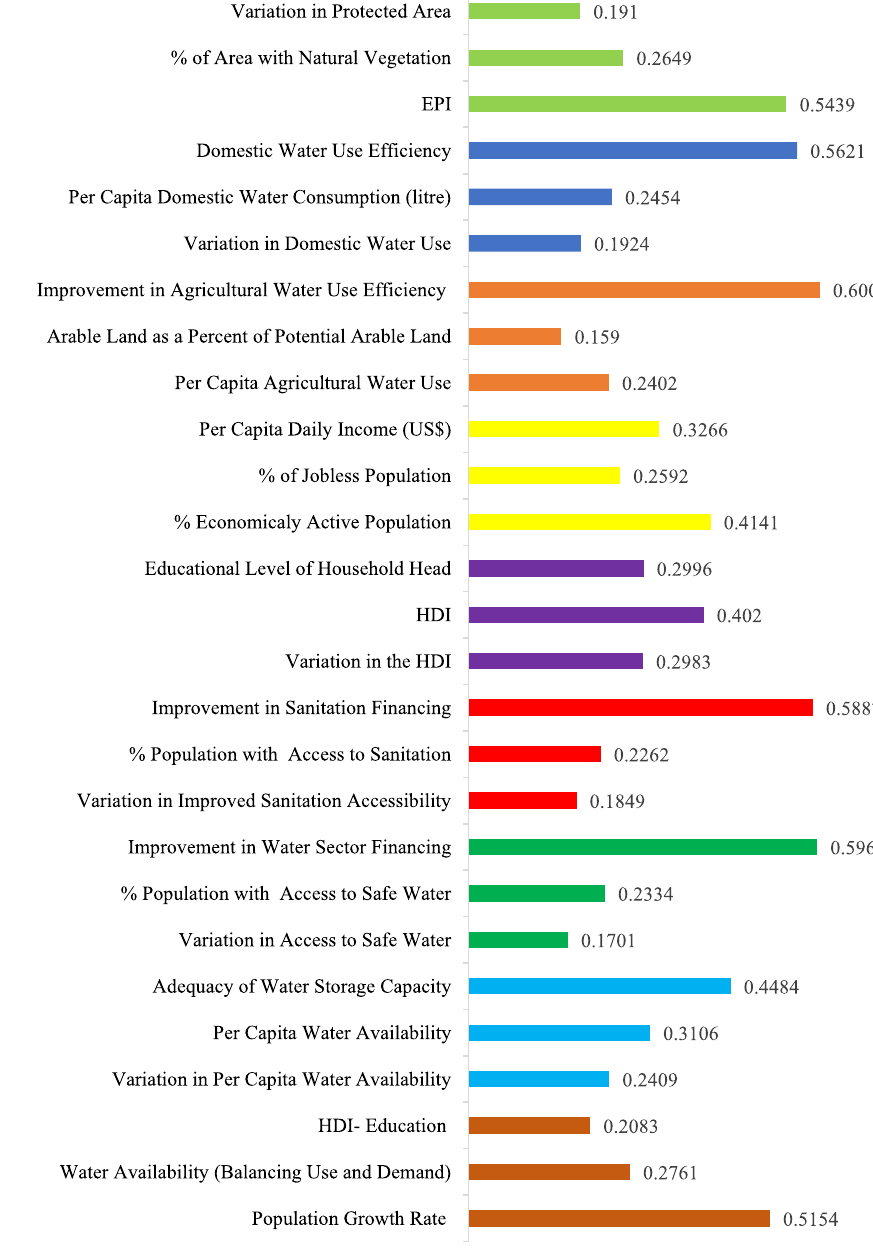
Fig. 4 eWPI parameters’ weights in